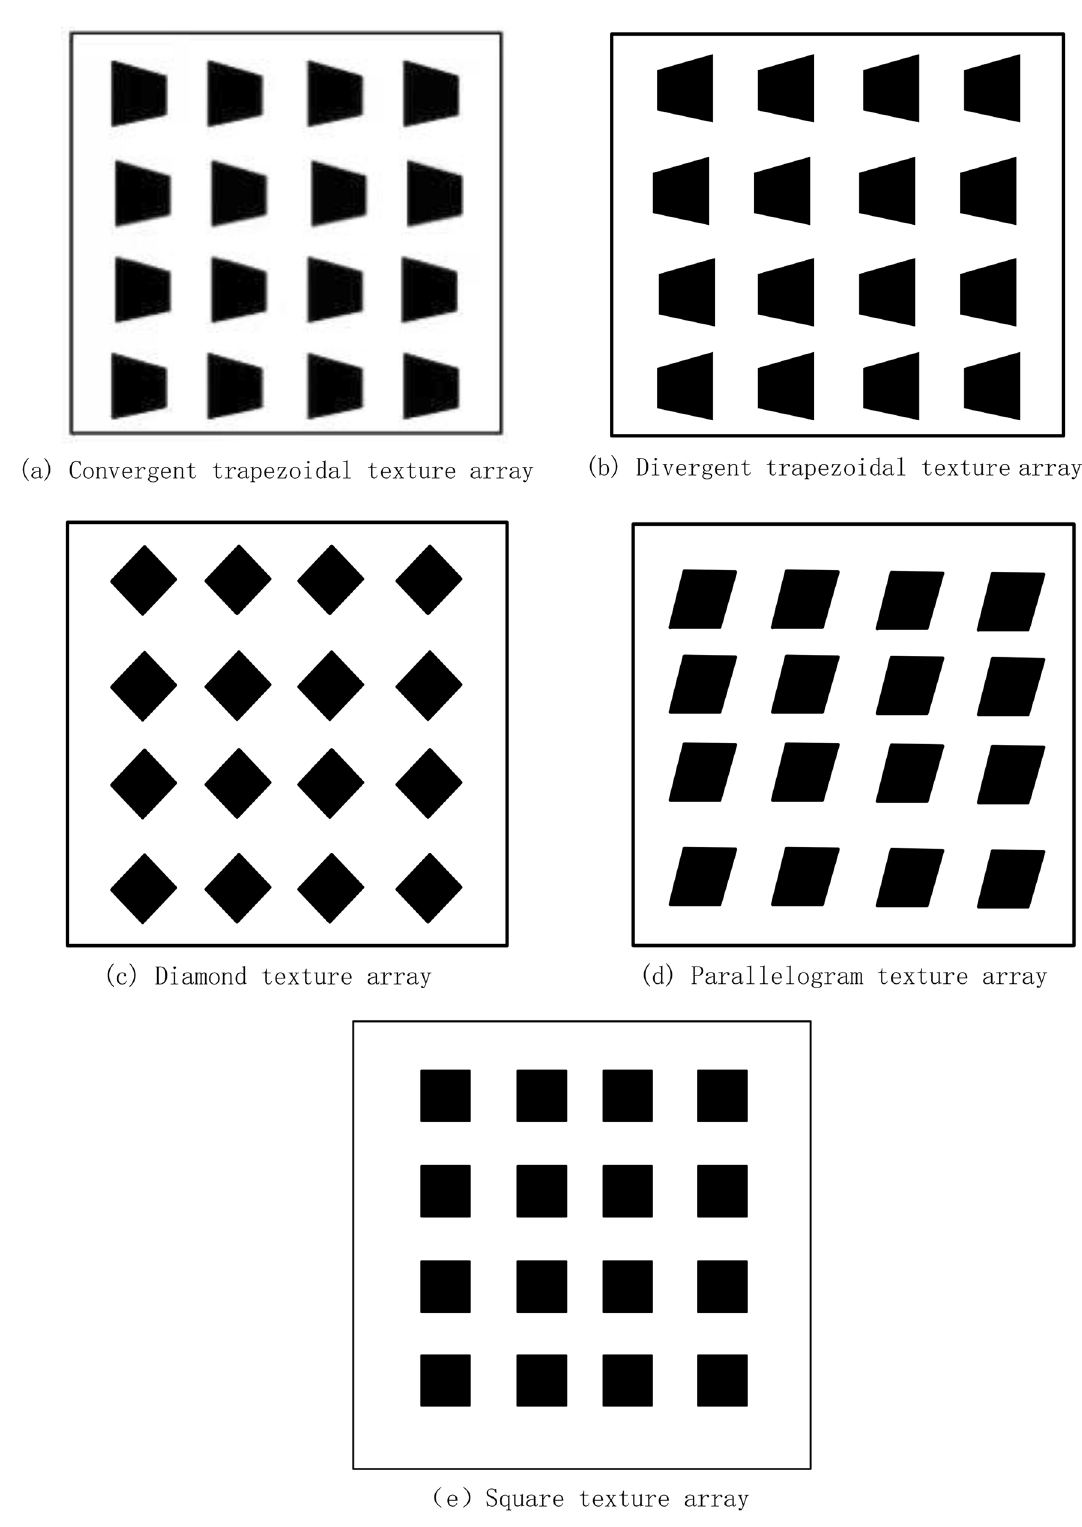
Figure 1. Five types of 4 × 4 microtexture array